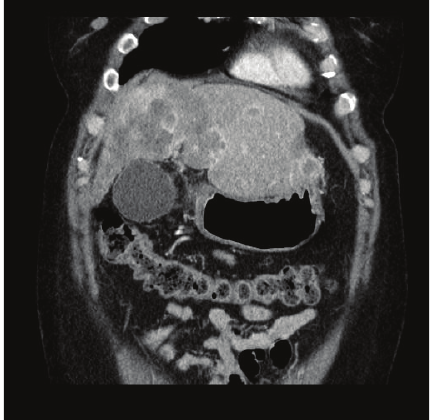
Figure 1: CT scan of the abdomen and pelvis.